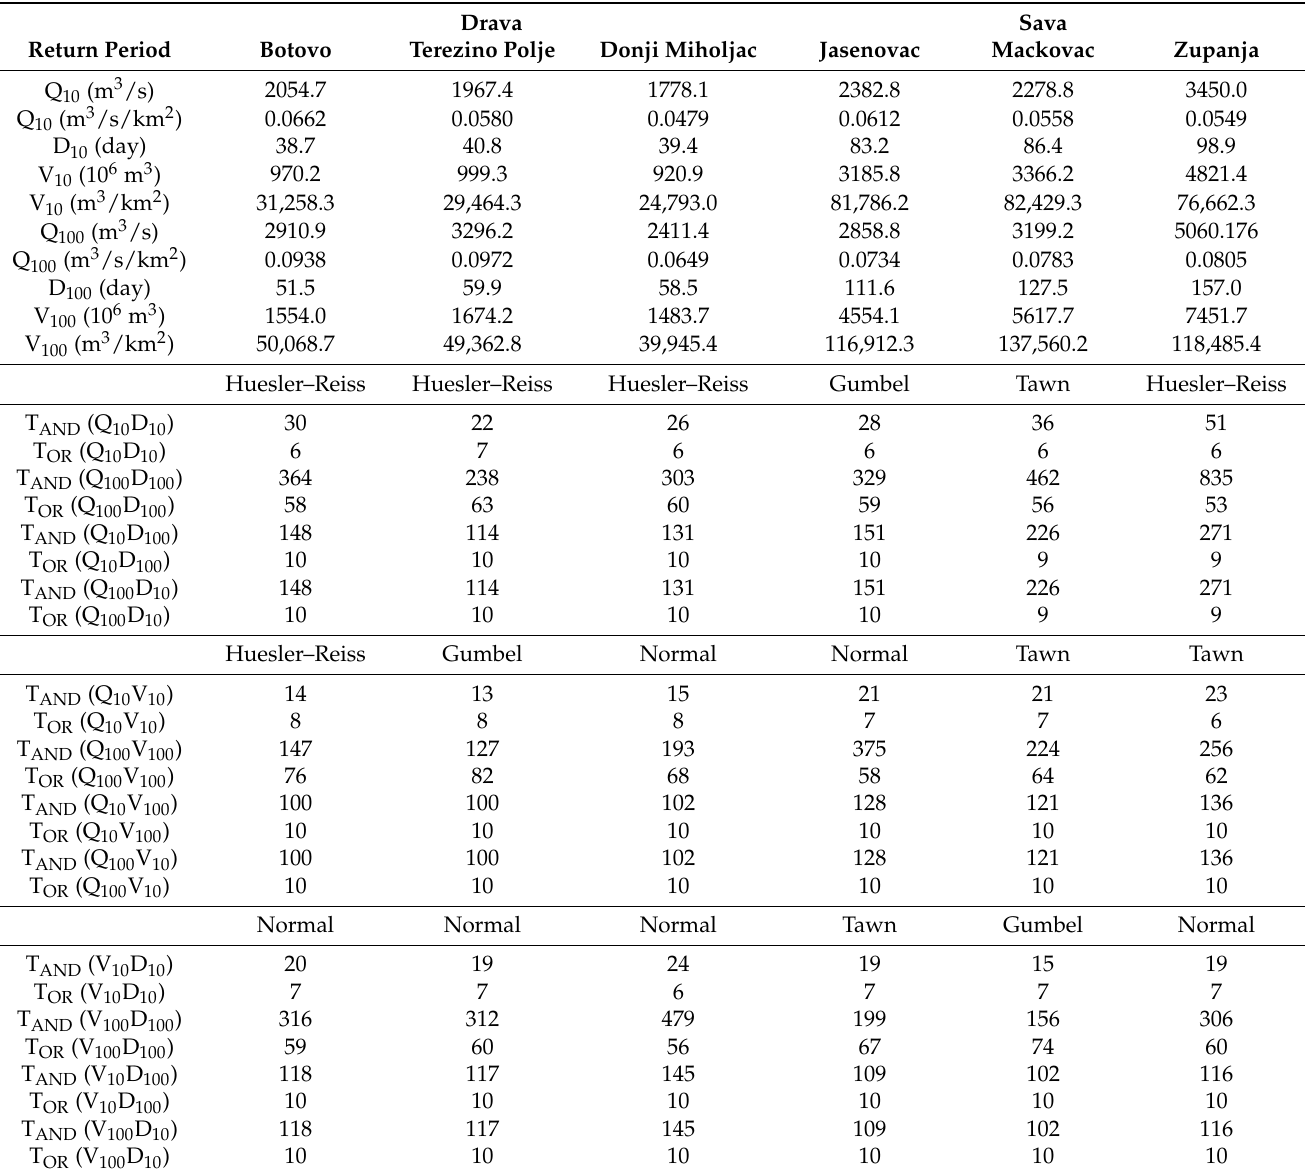
Table 10. Comparison of different return periods for variable pairs Q–D, Q–V, and V–D. Drava